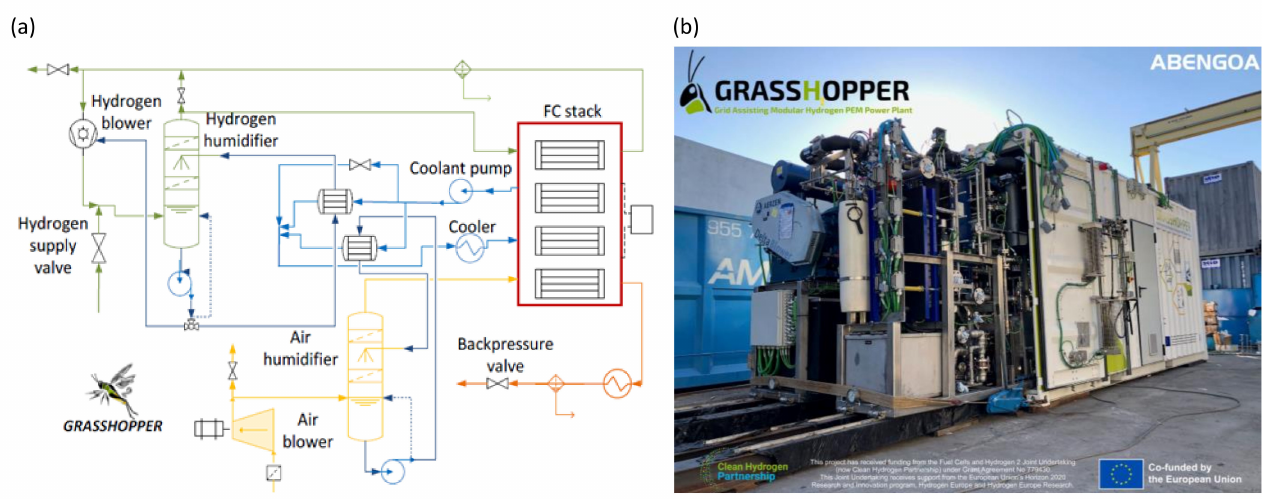
Figure 1. Grasshopper 100 kW el FC power plant ( a ) simplified layout and ( b ) real plant configuration showing the skid mounted and containerized structure of the